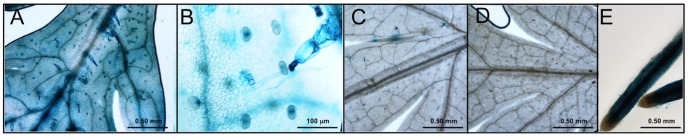
GUS expression controlled by the FS promoter in transgenic plants of Artemisia annua.A: young leaf; B: close-up of young leaf; C: leaf; D: old leaf; E: root.